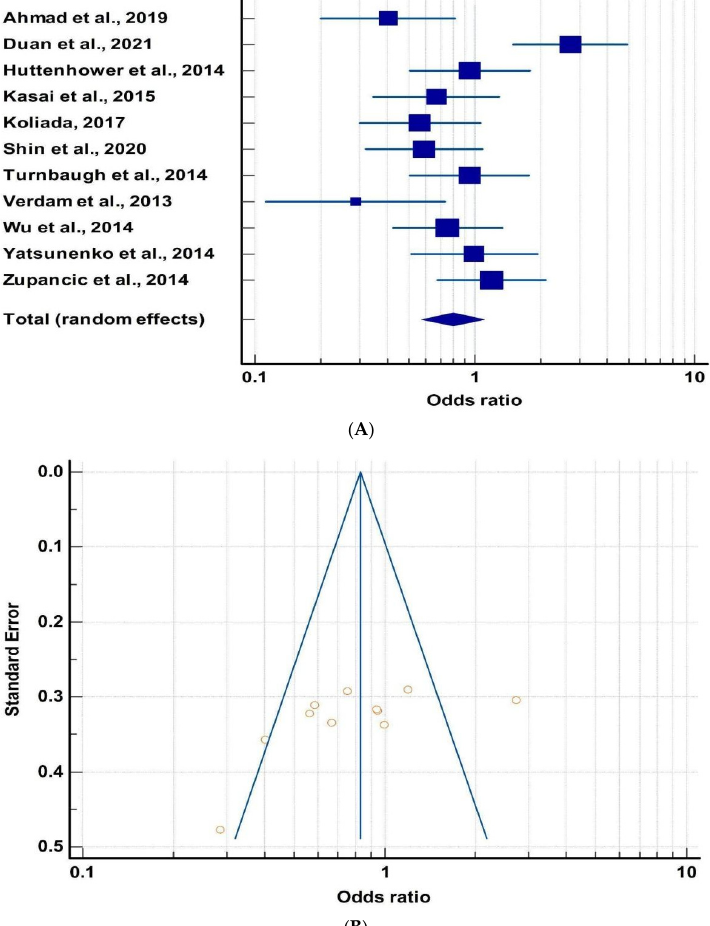
Figure 3. ( A ) Forest plot between obesity and microbiota [56–66]. The box and the horizontal lines represent study specific OR and 95% CI, respectively. The size of the box is an indicator of the weightage of that particular study. Here, odds ratio less than 1 suggest the relative abundance of Firmicutes is higher in obese people. ( B ) Funnel plot of obesity and microbiota for publication